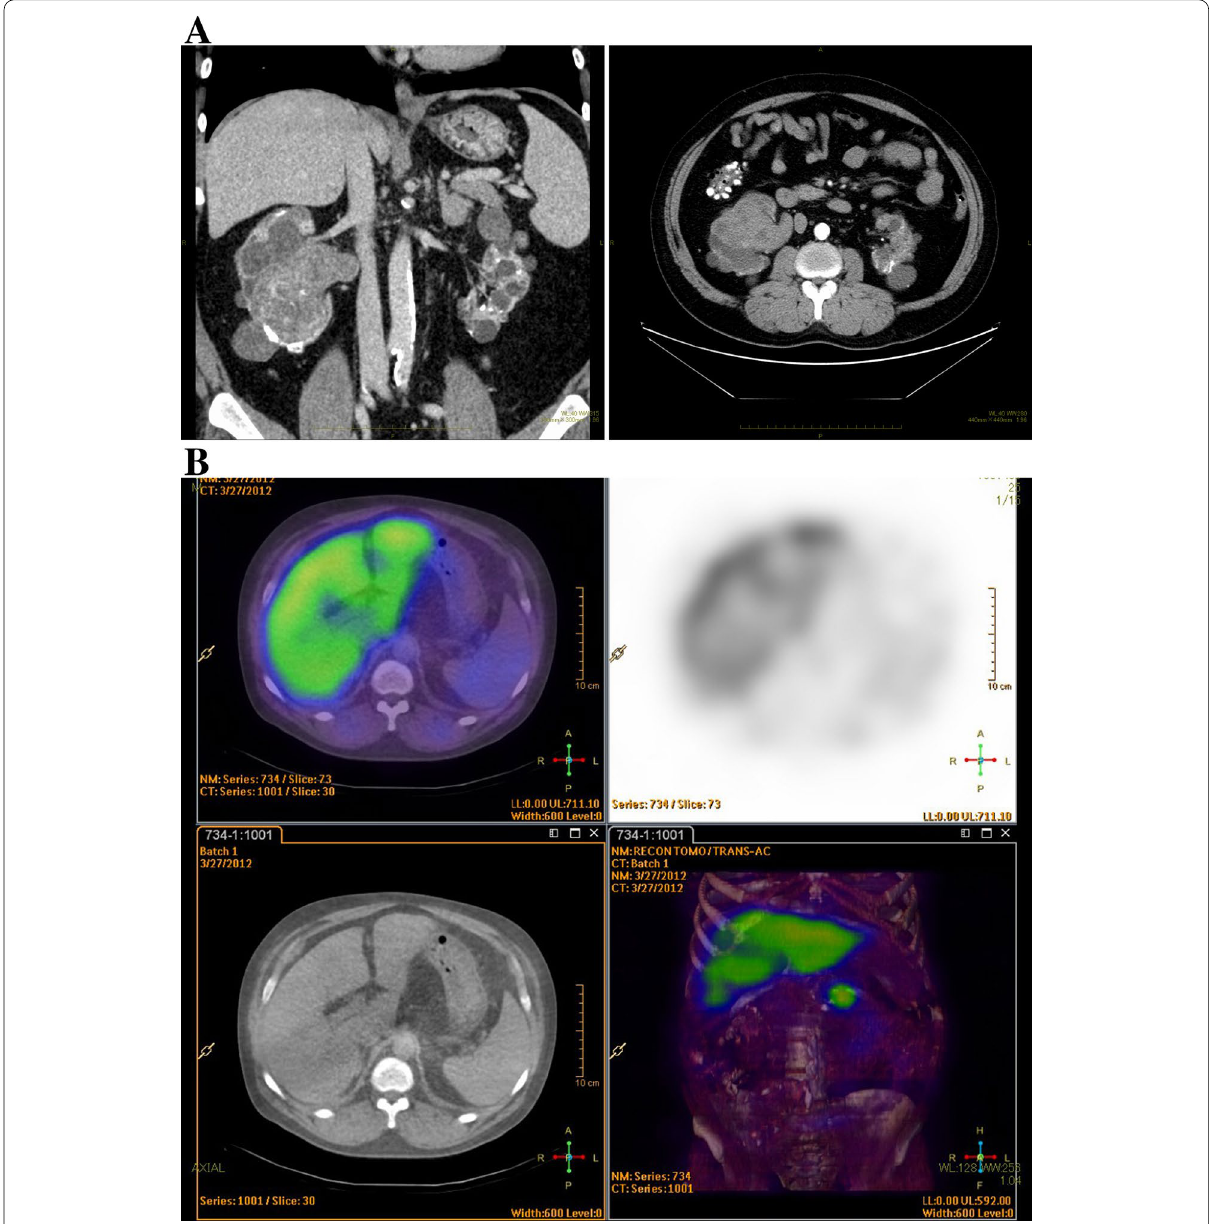
Fig. 2 Abdominal computed tomography ( A ) and 131 I-metaiodobenzylguanidine scintigraphy images ( B ). A Computed tomography showed multiple renal cysts in both kidneys, left kidney atrophy, and right renal pelvis tumor (64 131 I-metaiodobenzylguanidine corresponding to the adrenal